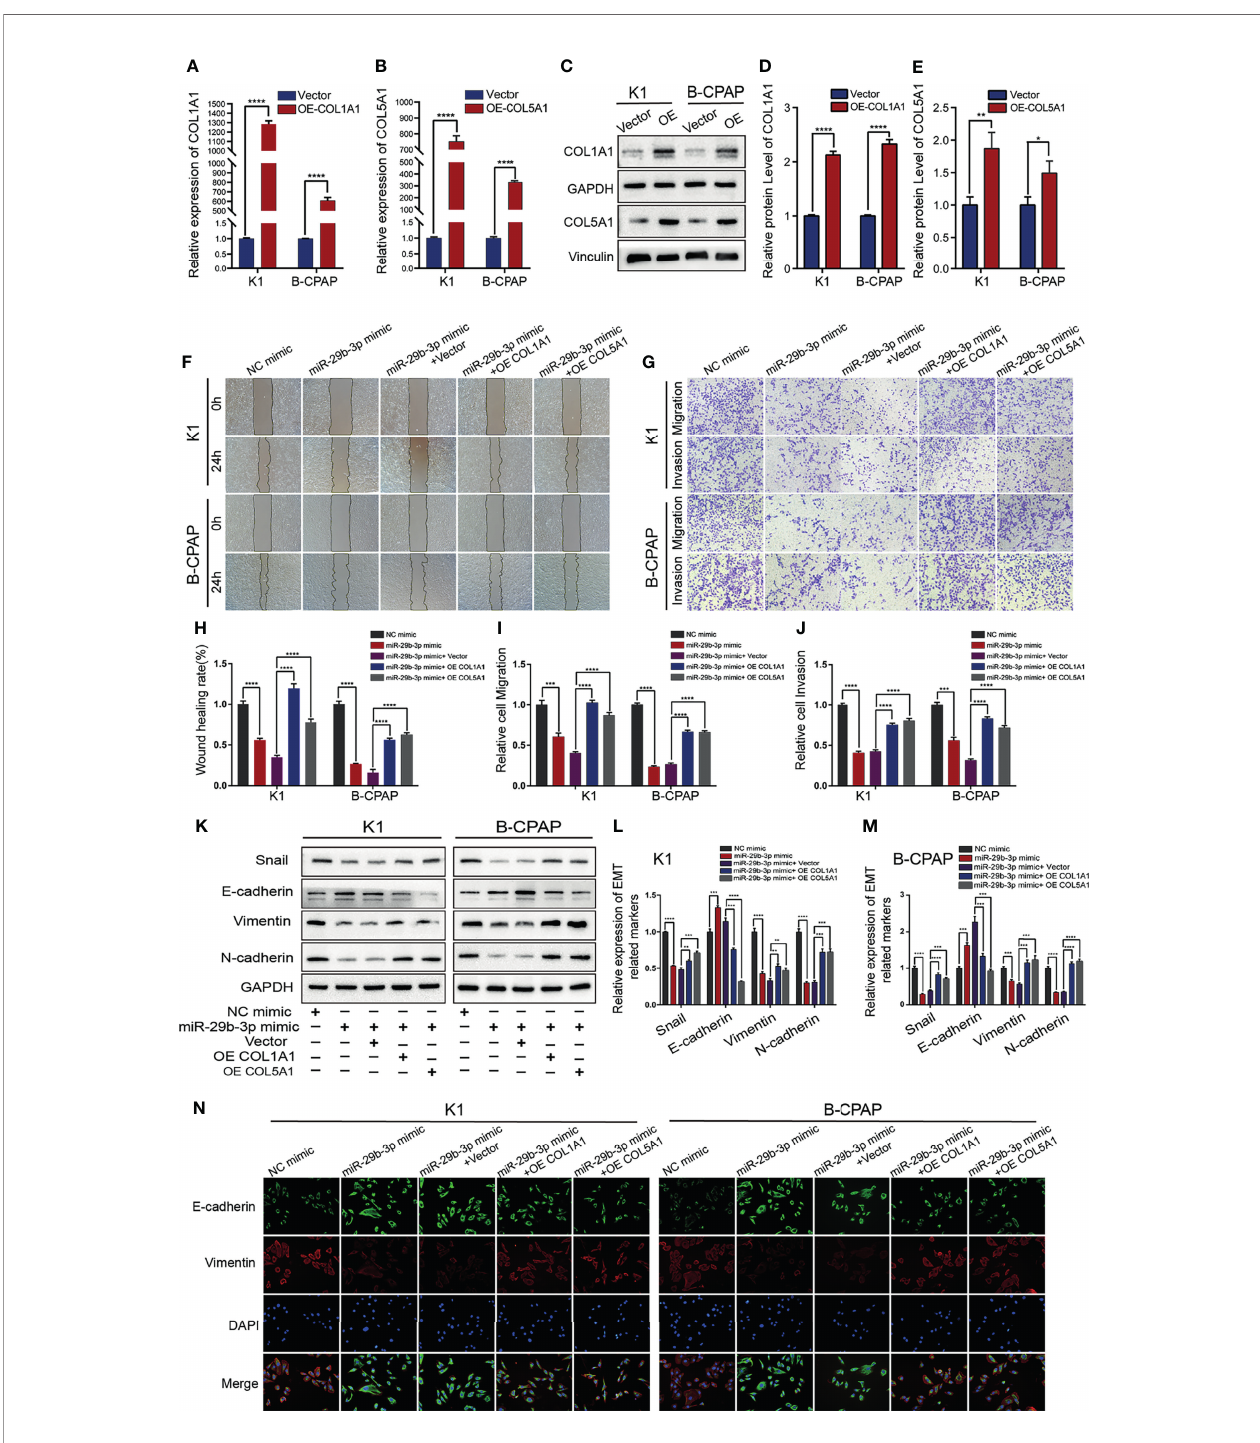
FIGURE 4 | Overexpression of COL1A1 or COL5A1 partially blocks the suppressive effects of miR-29b-3p on invasion in PTC cells. (A, B) qRT-PCR and (C) Western blot were performed to assess the transfection ef fi ciency of COL1A1 and COL5A1 overexpression plasmids. (D, E) Quanti fi cation of COL1A1 and COL5A1 levels in Western blot normalized over GAPDHand Vinculin. Thewound healing assays (F) and Transwell assays (G) demonstrated that the overexpression of COL1A1 and COL5A1 could ef fi ciently alleviate the miR-29b-3p mimic-induced inhibition of the migration and invasion activities of K1 and B-CPAP cells. (H – J) Quanti fi ed results of the wound-healing assays and Transwell assays. Inhibition of miR-29b-3p mimic-induced EMT by overexpressed COL1A1 or COL5A1; the EMT-related proteins were investigated by (K) Western blot and (N) immuno fl uorescence. (L, M) TheEMT-related proteins expression for each group was analyzed by Image J software. In the fi gure, *p < 0.05, **p < 0.01, ***p < 0.001, ****p <